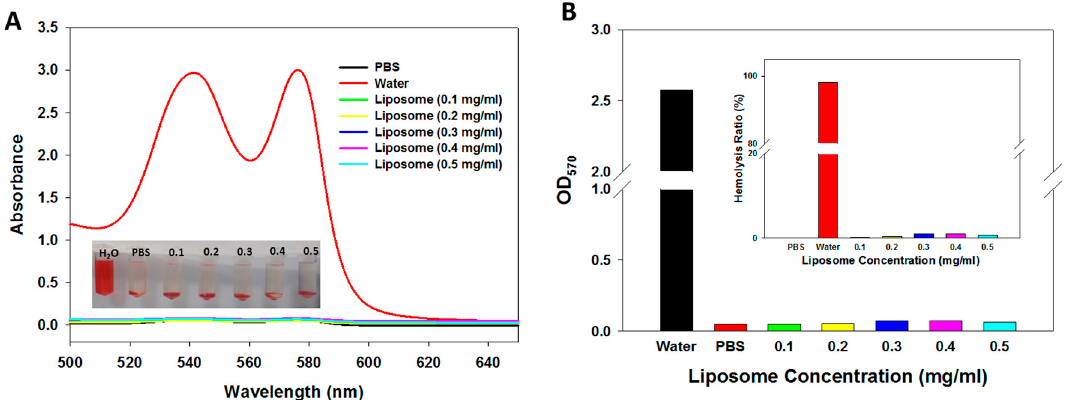
Figure 8. ( A ) Haemocompatibility of ImmuLip determined from the hemolysis assay after incubating ImmuLip with diluted red blood cells in phosphate buffered saline (PBS) at 37 °C for 2 h. Water and PBS were used as the positive and the negative controls, respectively. The full-wavelength absorption spectra of the supernatant as well as gross views of the samples (insert) are shown. ( B ) The absorbance at 570 nm (OD 570 ) were used to calculate the hemolysis ratio shown in the insert.